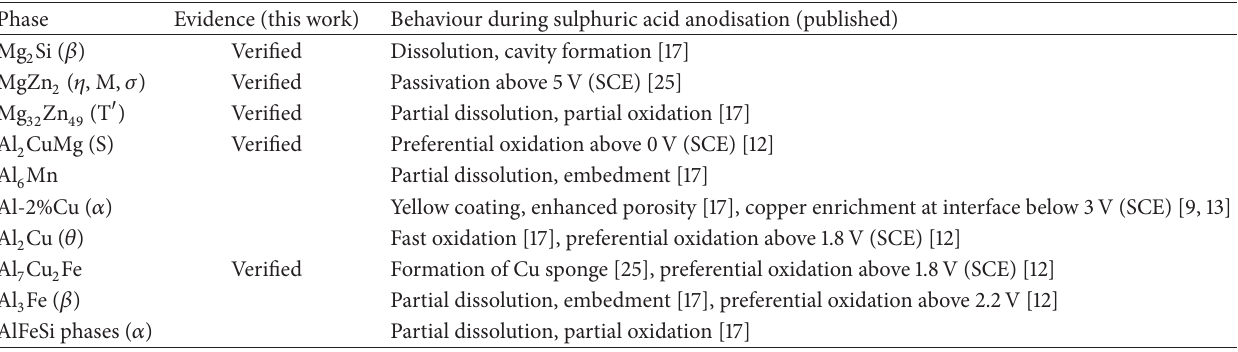
Table 3: IC particles in Al alloys and their behaviour during sulphuric acid